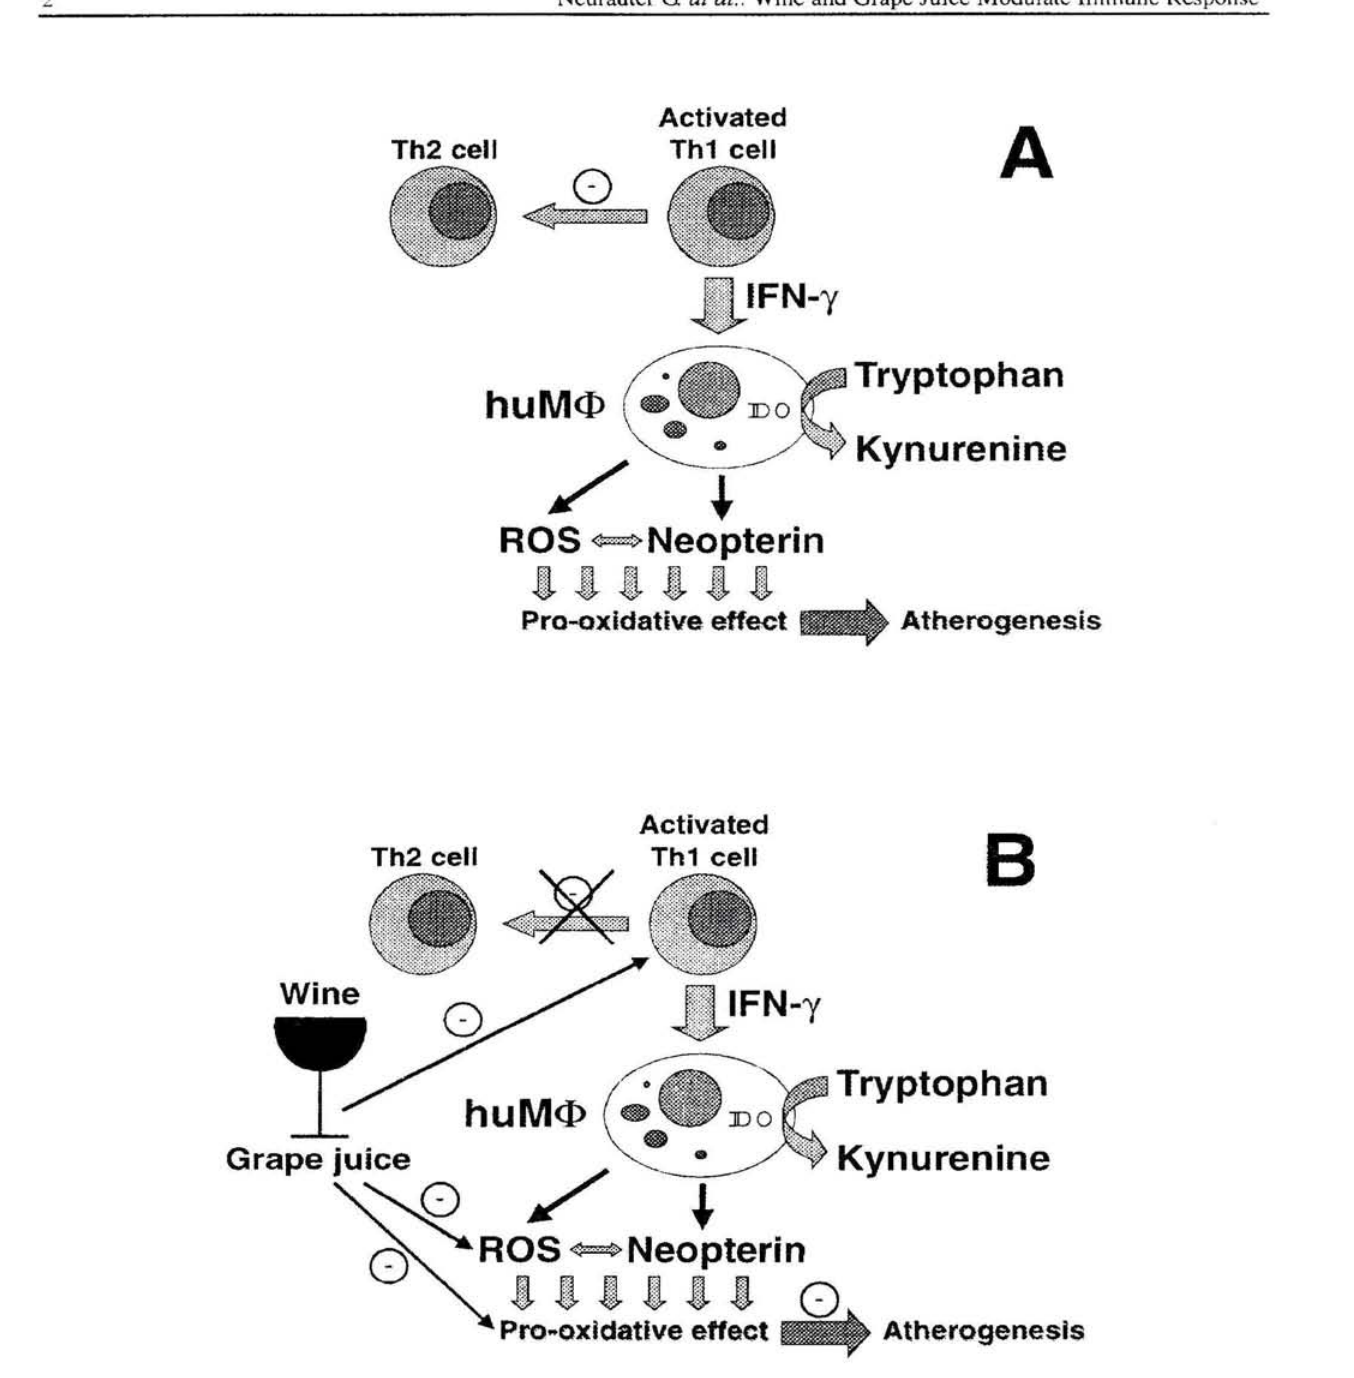
/. Hypothetical model how wine and grape juice may interfere with atherogenesis: Wiihin Thl -lype immune response, T-cells release cytokine interferon-y (IFN-y) which stimulates monocyte-derived macrophages (MO) to produce neopterin and to degrade tryptophan to form kynurenine via induction of indoleamine (2,3)- dioxygcnase (IDO). In parallel, IFN-y induces the production of reactive oxygen species (ROS). By deplction of anüoxidants, oxidative stress develops which is decply involved in atherogenesis. Due to cross-regulation, acti- vated Thl-type immune response slows-down Th2-type cells and cytokines (left). Most likely due to their antiox- idative ingredients, wine and grape juice cuunleract oxidative stress by direct chenücal neutralization of ROS and reducing IFN-y production by Thl cells. Production of neopterin and ROS declines, risk of coronary hcart dis- eases is declining as well as degradation of tryptophan ceases (right). However, slowing-down Thl-type immune response may mcrease the risk for allergic reactions simply by forward-regulating Th2-type immunity (right).